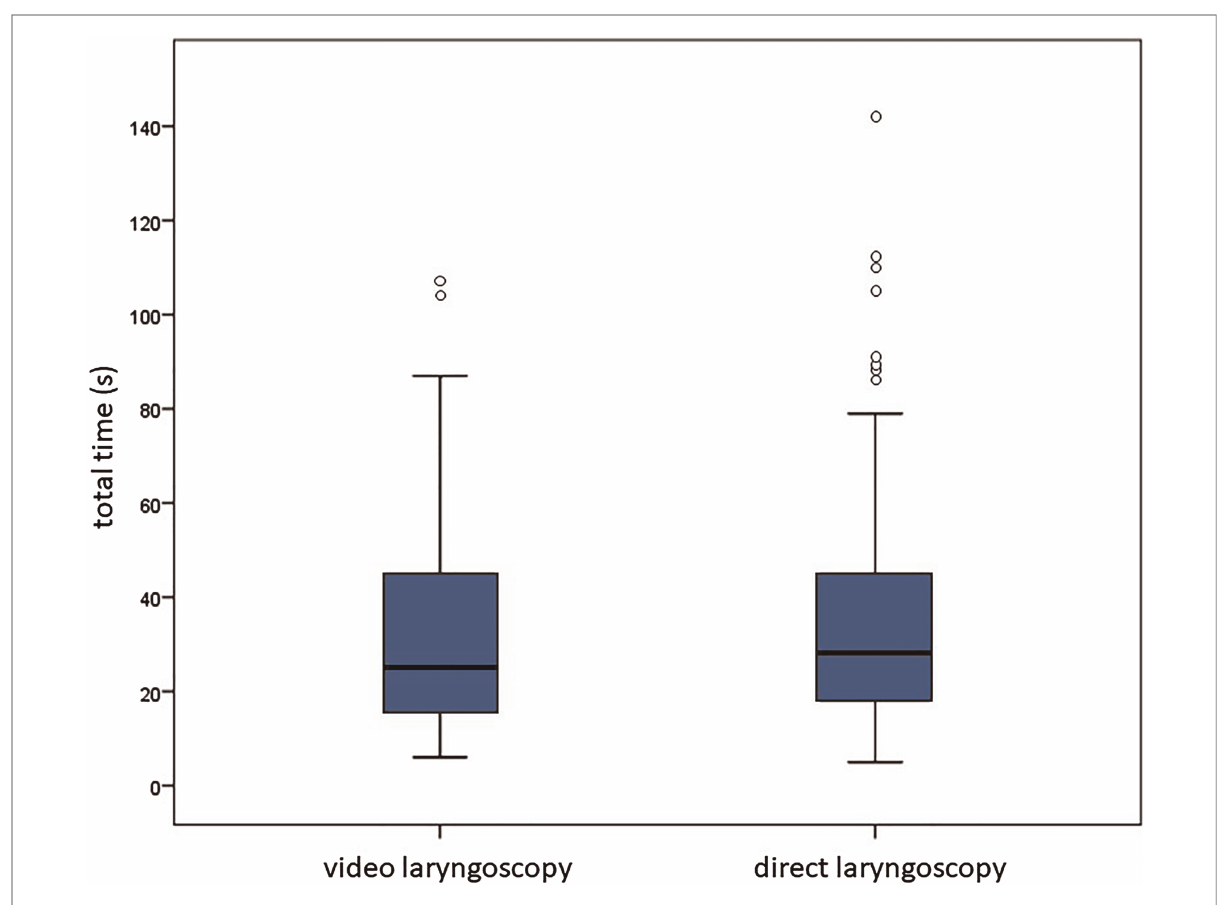
FIGURE 1 Total time for intubation in seconds (s): video laryngoscopy: median, min/max: 26, 6/107; direct laryngoscopy: median, min/max: 29, 5/142.